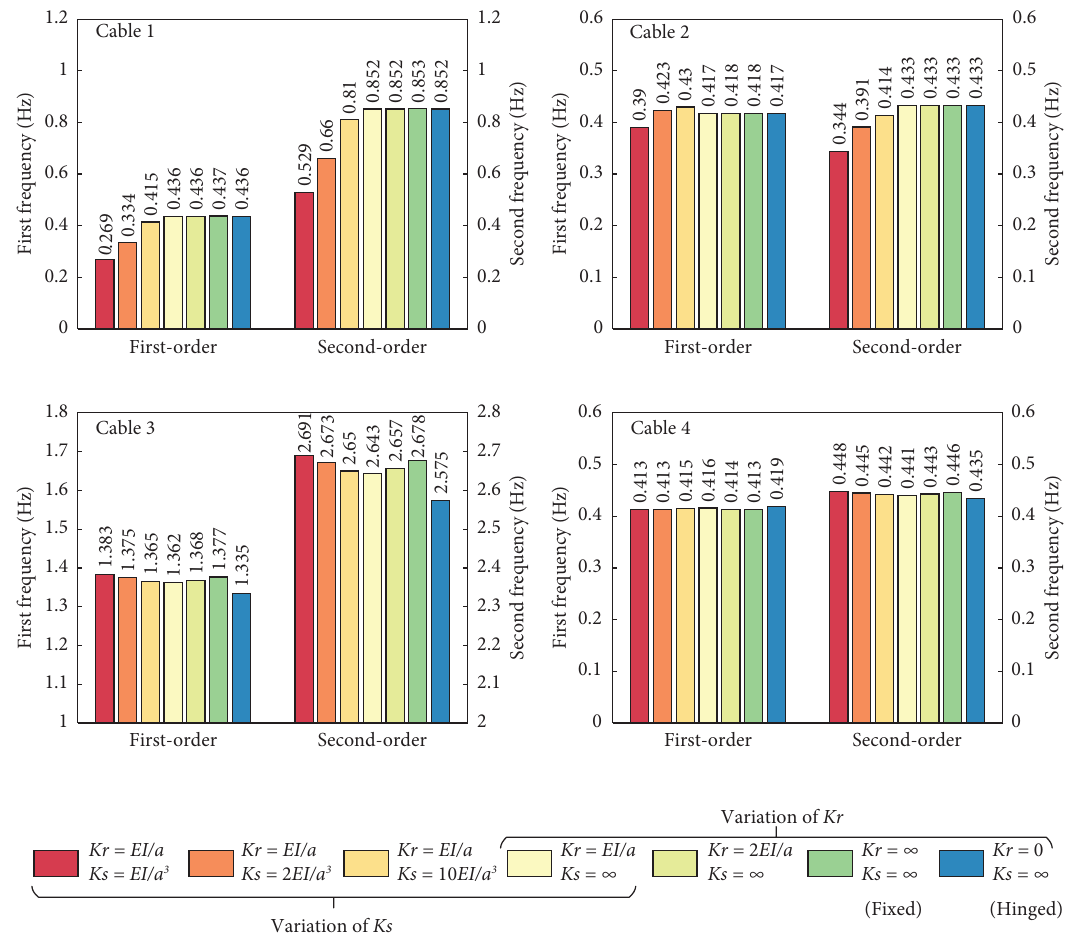
Figure 7: Infuence of boundary constraint stifnesses on cable’s frst two vibration